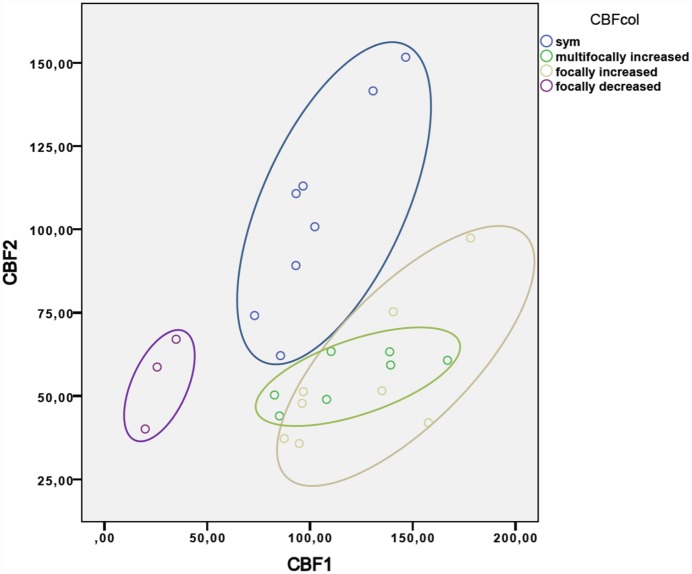
Scatter plot of quantified CBF.Each patient group is represented in an oval: group 1, blue oval; group 2, green oval; group 3, grey oval; group 4, purple oval. x-axis (CBF1): CBF value in ml/100 g/min of ill-perfused parenchyma y-axis (CBF2): CBF value in ml/100 g/min of the contralateral side. Group 1 shows a global hyperperfusion with mostly high CBF values in both hemispheres (x- and y-axis: >75 ml/100 g/min). Groups 2 and 3 show mainly unilateral higher CBF values (x-axis: >75 ml/100 g/min) and mostly normal CBF values on the opposite side (y-axis: around 50 ml/100 g/min). For group 4, CBF values are low in the ill-perfused area (x-axis: <50 ml/100 g/min), while the CBF values on the contralateral side are mostly in the normal range (y-axis: around 50 ml/100 g/min).